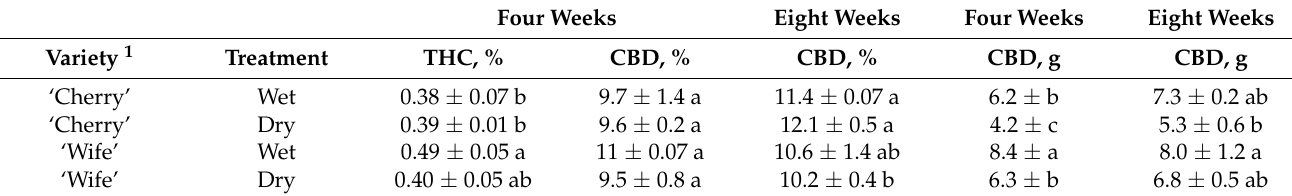
Table 2. Cannabinoid (THC—tetrahydrocannabinol—and CBD—cannabidiol) concentration and yield (flower weight x concentration) at four and eight weeks into flowering. Values within a column separated by letters are significantly different at p < 0.05 using Tukey’s post-hoc HSD test ( n = 4), plus standard deviation. Four Weeks Eight Weeks Four Weeks Eight